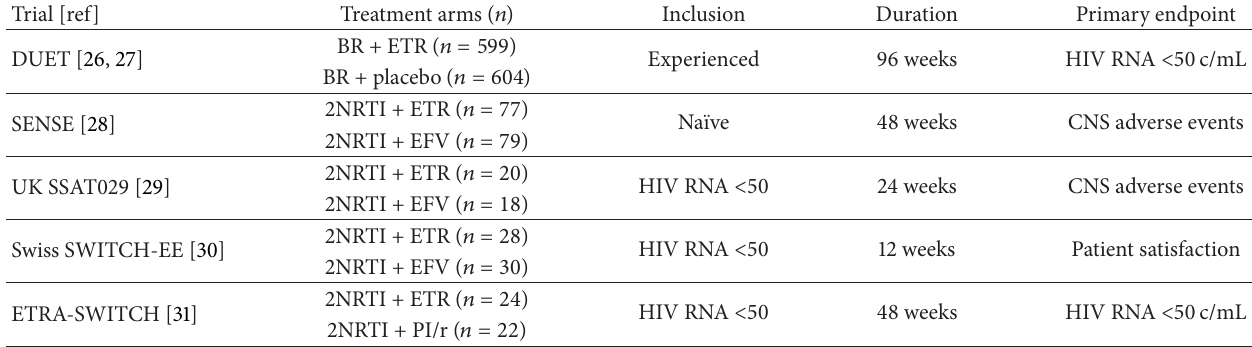
Table 1: Design of the six main randomized trials of etravirine.